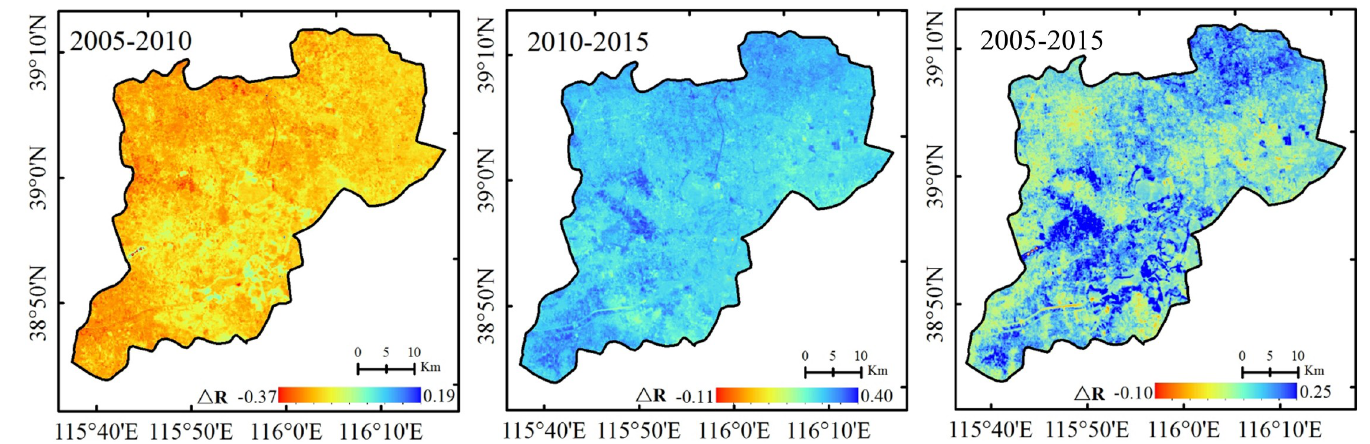
Fig 8. Change in the water conservation function for the Xiongan New Area from 2005 to 2010, 2010 to 2015 and 2010 to 2015.